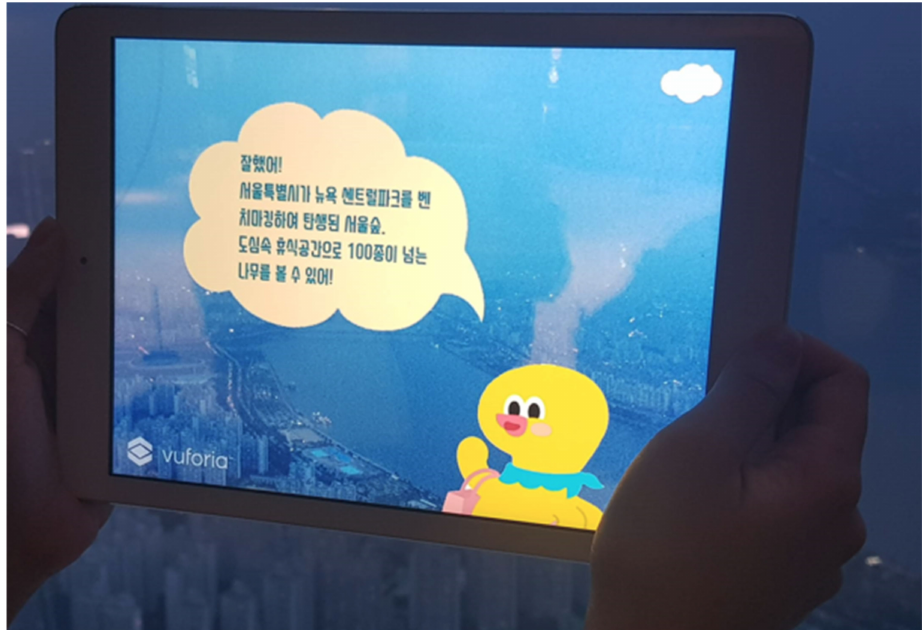
Figure 8. After successfully completing Mission 2, the user can see a brief description of the relevant